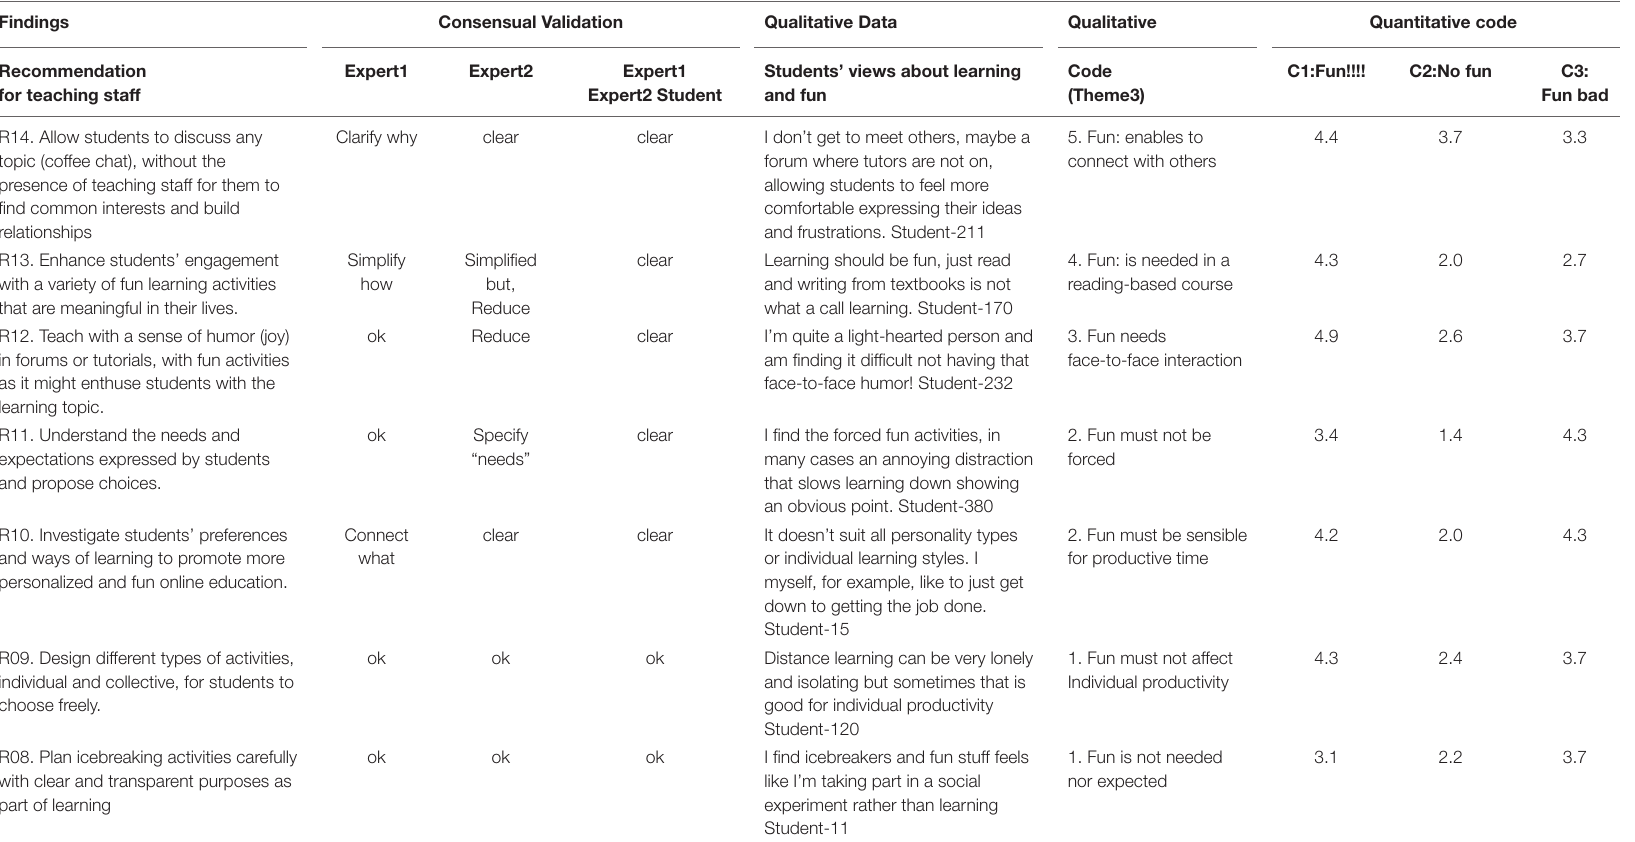
TABLE 4 | Recommendations about Online Learning and Fun for teaching staff supported by mixed methods.